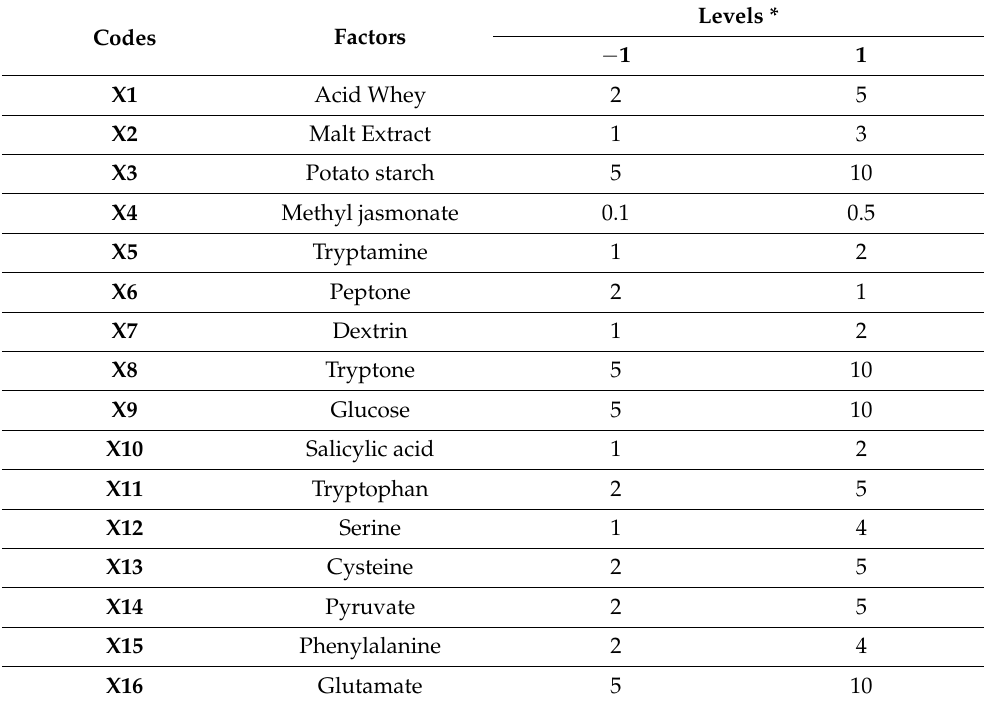
Table 2. The coded and actual values for the tested variables affecting CPT production by P. chrysogenum .